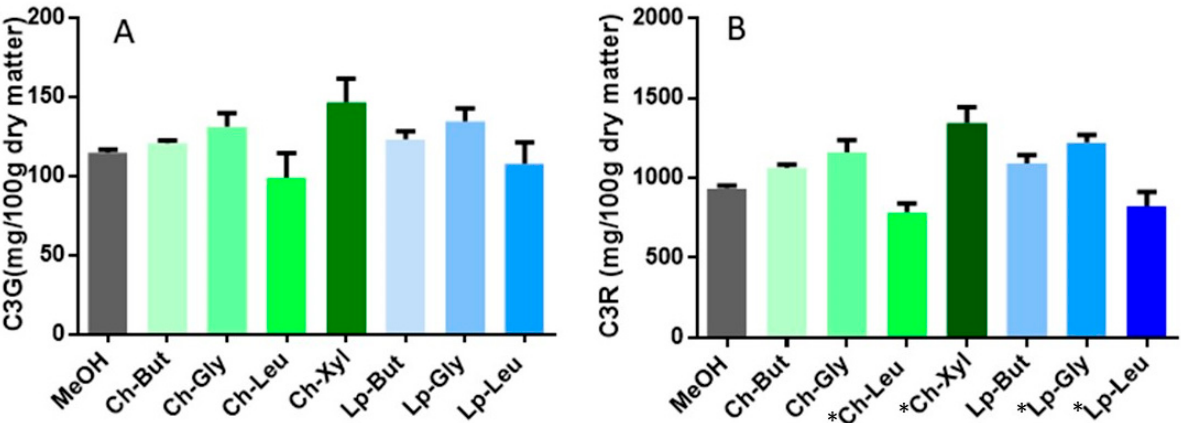
Figure 1. Cyanidin 3-glucoside ( A ) and Cyanidin 3-rutinoside ( B ) concentration (mg 100 g − 1 dry matter) in different extracts of eutectic solvents tested in lyophilized jussara samples. The * marks DES mixtures with results statistically different from the control (MeOH).